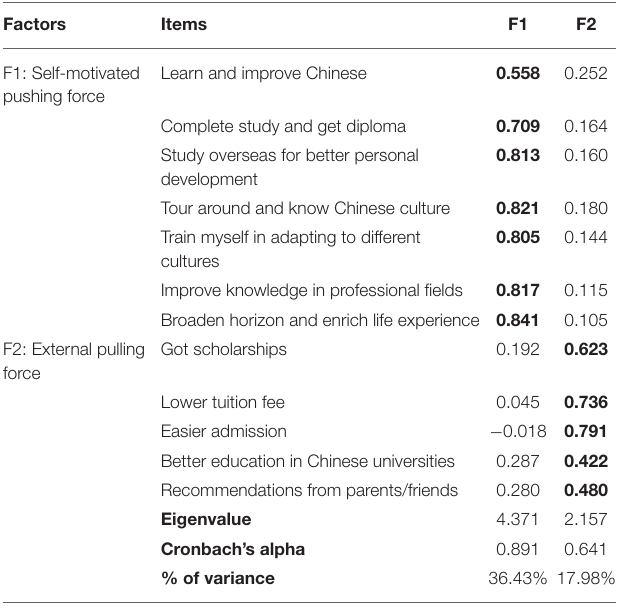
TABLE 4 | Principal components analysis ( N =